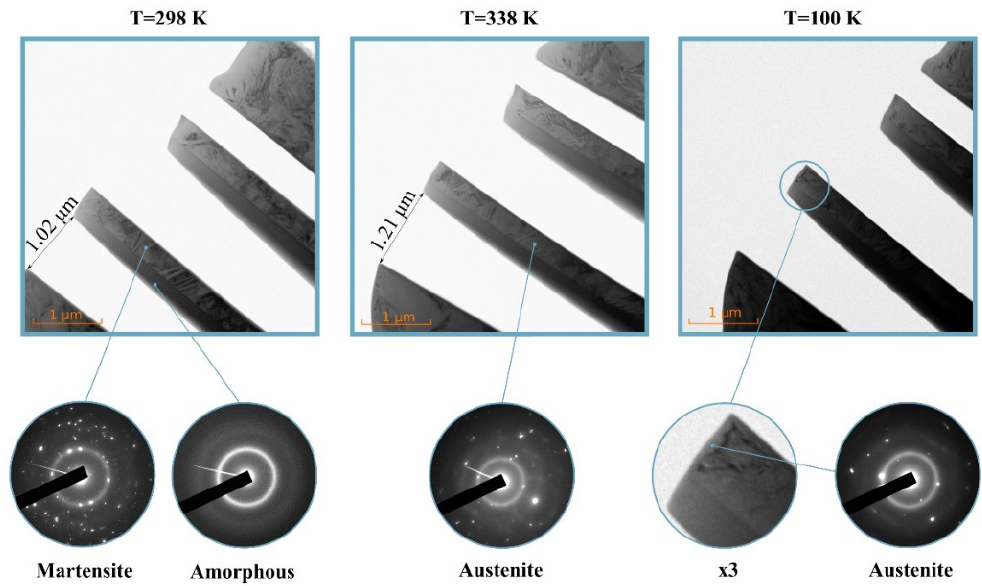
Figure 3. Structure and shape of nano actuators in TEM ( in-situ ) at different temperatures during thermal cycling.